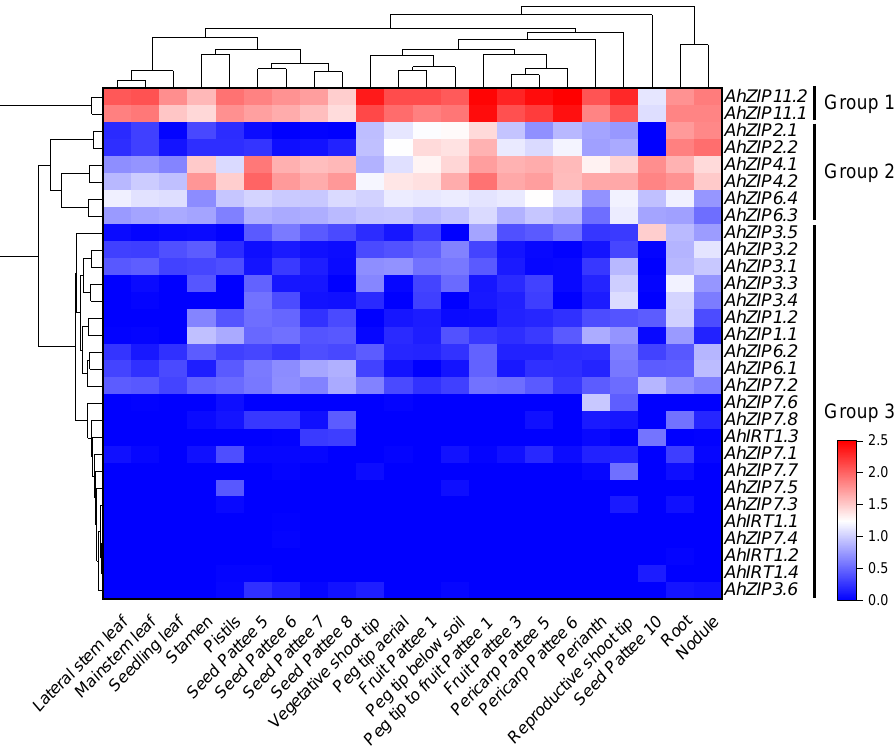
Figure 6. Expression profiles of AhZIP genes across the different tissues. Gene expression is expressed in lg(TPM + 1). Pattee 1, 3, 5, 6, 7, 8 and 10 represent different developmental stages of peanut pods according to Pattee et al. [42], who classified peanut pod maturity into 15 categories.